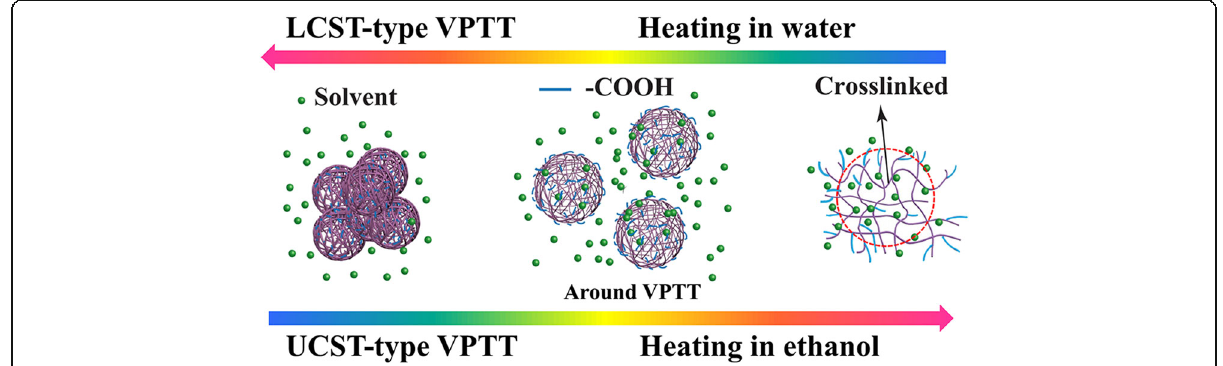
Fig. 7 Schematic illustration of the VPTT mechanism for the UCST-type VPTT of P(OEGDA-MAA) in